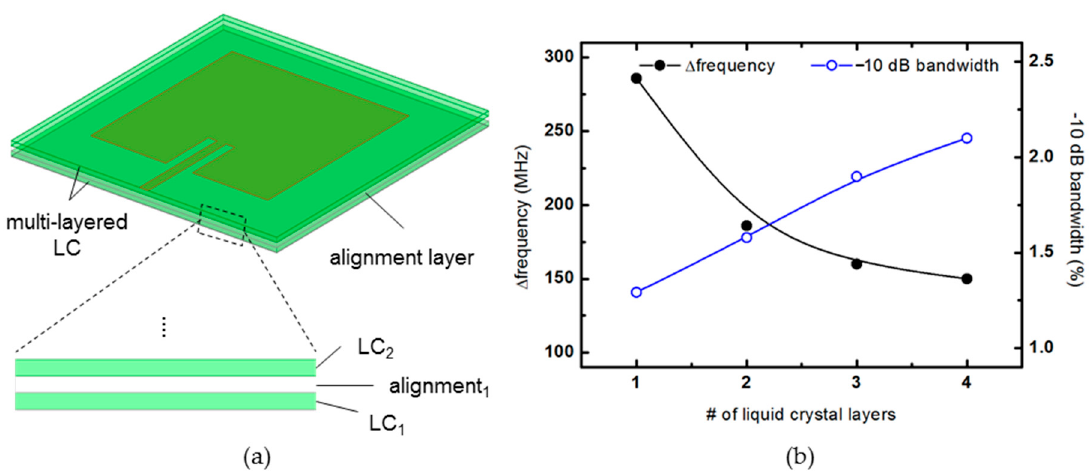
Figure 10. ( a ) 3D view and detail of the multi-layered LC substrate. ( b ) Frequency change rate and − 10 dB bandwidth according to the number of liquid crystal layers.